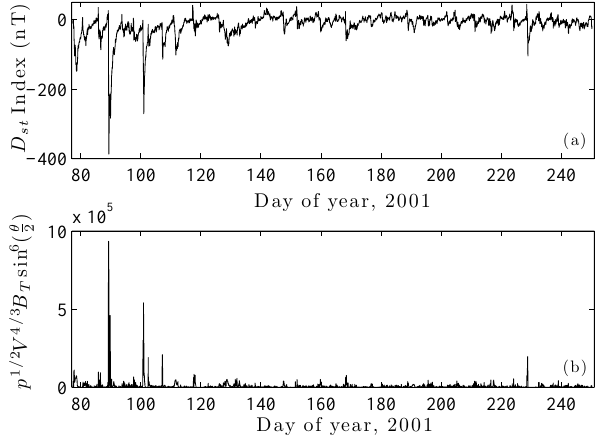
Fig. 1. Output and intput for training the model. (a) The output to the system Dst index. (b) The input to the system coupling func- tion C .